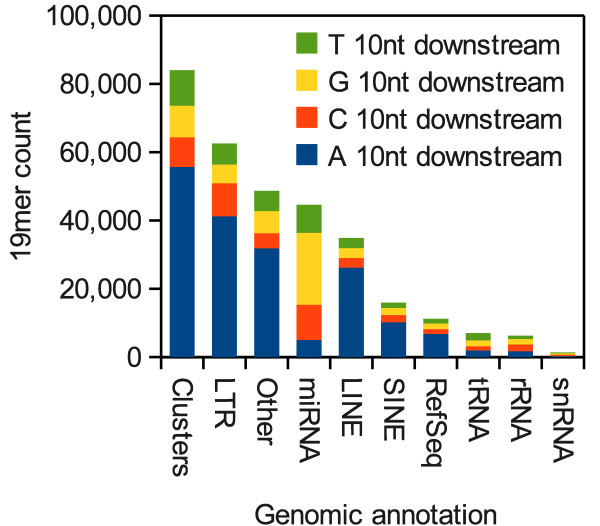
Genomic annotation of all spermatogenic tubule 19mers The origin of all 19mers from the spermatogenic tubule deep sequencing dataset were deduced from overlap with elements annotated in the UCSC Genome Browser [15]. The "Clusters" category refers to 94 pachytene piRNA clusters annotated by Lau et al. [20] and includes all 19mers mapped to these that were not otherwise annotated. The category "LTR" includes all Long Terminal Repeat sequences, including the Intracisternal A-Particle. Reads that mapped to multiple loci were randomly assigned to single loci.